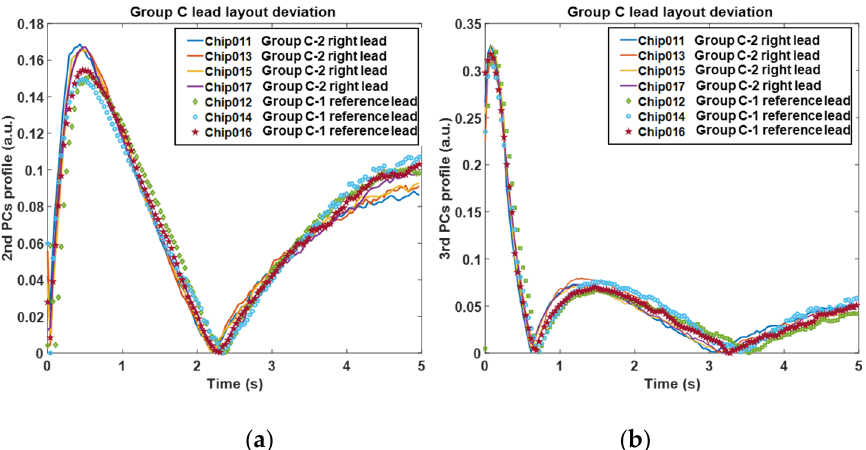
Figure 12. Feature results of the 1st verification comparison; ( a ) the 2nd principal component profiles; ( b ) the 3rd principal component profiles.